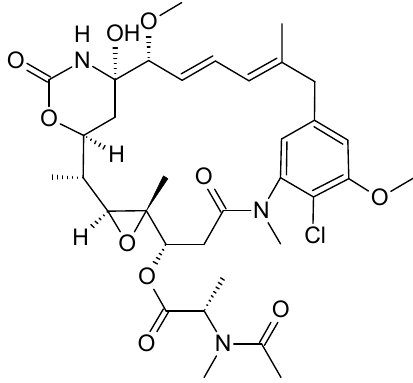
Figure 3. Structure of